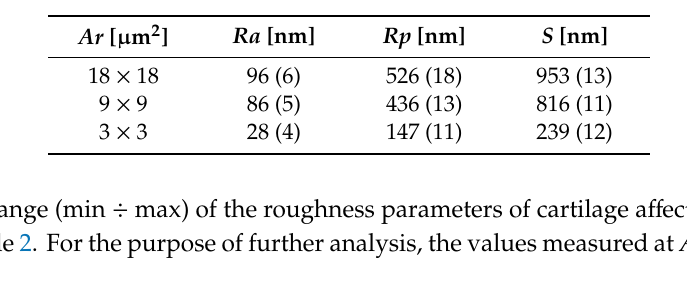
Figure 4. AFM images of a worn human surface: ( a ) 9 × 9 µm 2 , Zmax = 405 nm, and ( b ) 3 × 3 µm 2 , Zmax = 25 nm.